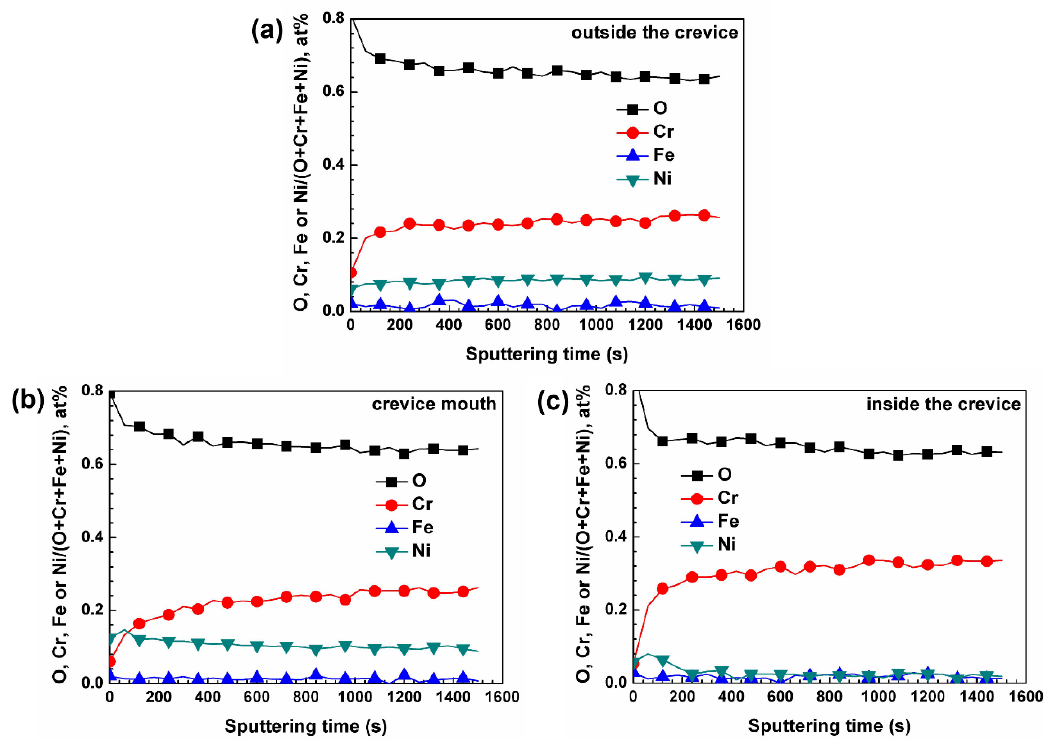
Figure 5. XPS depth profiles of the oxide films formed at different regions of crevice sample exposed to 290 °C NaCl solution: ( a ) outside the crevice, ( b ) crevice mouth, ( c ) inside the crevice.